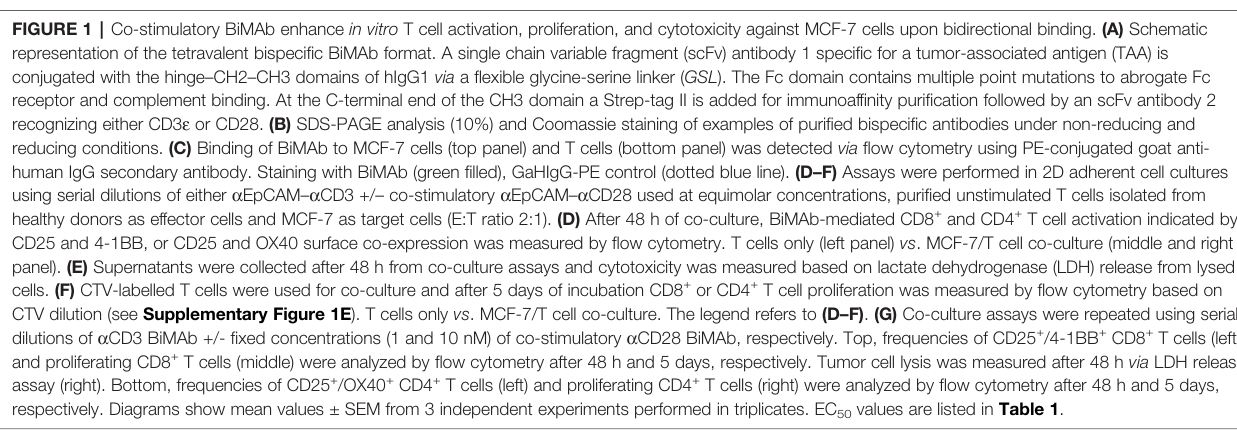
FIGURE 1 | Co-stimulatory BiMAb enhance in vitro T cell activation, proliferation, and cytotoxicity against MCF-7 cells upon bidirectional binding. (A) Schematic representation of the tetravalent bispeci fi c BiMAb format. A single chain variable fragment (scFv) antibody 1 speci fi c for a tumor-associated antigen (TAA) is conjugated with the hinge – CH2 – CH3 domains of hIgG1 via a fl exible glycine-serine linker ( GSL ). The Fc domain contains multiple point mutations to abrogate Fc receptor and complement binding. At the C-terminal end of the CH3 domain a Strep-tag II is added for immunoaf fi nity puri fi cation followed by an scFv antibody 2 recognizing either CD3 e or CD28. (B) SDS-PAGE analysis (10%) and Coomassie staining of examples of puri fi ed bispeci fi c antibodies under non-reducing and reducing conditions. (C) Binding of BiMAb to MCF-7 cells (top panel) and T cells (bottom panel) was detected via fl ow cytometry using PE-conjugated goat anti- human IgG secondary antibody. Staining with BiMAb (green fi lled), GaHIgG-PE control (dotted blue line). (D – F) Assays were performed in 2D adherent cell cultures using serial dilutions of either a EpCAM – a CD3 +/ – co-stimulatory a EpCAM – a CD28 used at equimolar concentrations, puri fi ed unstimulated T cells isolated from healthy donors as effector cells and MCF-7 as target cells (E:T ratio 2:1). (D) After 48 h of co-culture, BiMAb-mediated CD8 + and CD4 + T cell activation indicated by CD25 and 4-1BB, or CD25 and OX40 surface co-expression was measured by fl ow cytometry. T cells only (left panel) vs . MCF-7/T cell co-culture (middle and right panel). (E) Supernatants were collected after 48 h from co-culture assays and cytotoxicity was measured based on lactate dehydrogenase (LDH) release from lysed cells. (F) CTV-labelled T cells were used for co-culture and after 5 days of incubation CD8 + or CD4 + T cell proliferation was measured by fl ow cytometry based on CTV dilution (see Supplementary Figure 1E ). T cells only vs . MCF-7/T cell co-culture. The legend refers to (D – F) . (G) Co-culture assays were repeated using serial dilutions of a CD3 BiMAb +/- fi xed concentrations (1 and 10 nM) of co-stimulatory a CD28 BiMAb, respectively. Top, frequencies of CD25 + /4-1BB + CD8 + T cells (left) and proliferating CD8 + T cells (middle) were analyzed by fl ow cytometry after 48 h and 5 days, respectively. Tumor cell lysis was measured after 48 h via LDH release assay (right). Bottom, frequencies of CD25 + /OX40 + CD4 + T cells (left) and proliferating CD4 + T cells (right) were analyzed by fl ow cytometry after 48 h and 5 days,